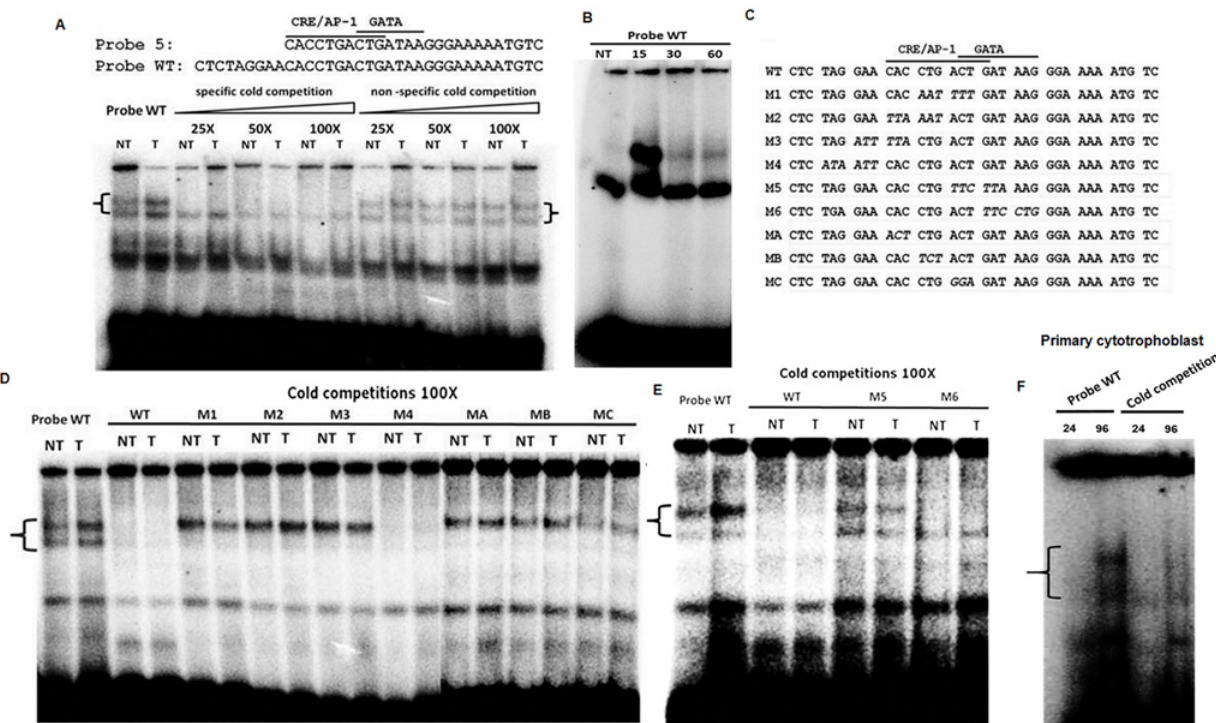
Fig 3. Identification of a CRE/AP-1-like motif and GATA-binding site within the Syncytin-2 promoter. (A) Extended probe 5 (termed WT) (from-211 to- 177) (indicated in the upper part of the panel) was used for EMSA analyses and highlights the CRE/AP-1-like motif and the potential GATA-binding site in the Syncytin-2 promoter. Nuclear extracts from BeWo cells treated (T) or not (NT) with forskolin for 15 min were pre-incubated with different concentrations of cold specific or non-specific oligonucleotides prior to addition of the labeled WT probe. ( B ) EMSA analyses of nuclear extracts from BeWo cells stimulated with forskolin at different time points and incubated with the WT probe. (C) Representation of the various oligonucleotides bearing mutated sequences (nucleotides in italic) used in EMSA analyses. (D-E) Nuclear extracts from non-treated (NT) or forskolin-treated (T) BeWo cells were incubated with the WT probe and excess (100X) cold WT or mutated oligonucleotides presented in ( C ). Specific DNA-protein complexes are indicated on left side of panels. ( F ) Nuclear extracts from primary villous cytotrophoblasts cultured for 24 and 96 hours were incubated with the WT probe and with or without excess (100X) cold WT